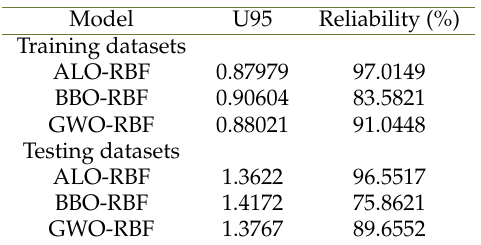
Table 3. Comparisons of the performance results for the uncertainty, and reliability